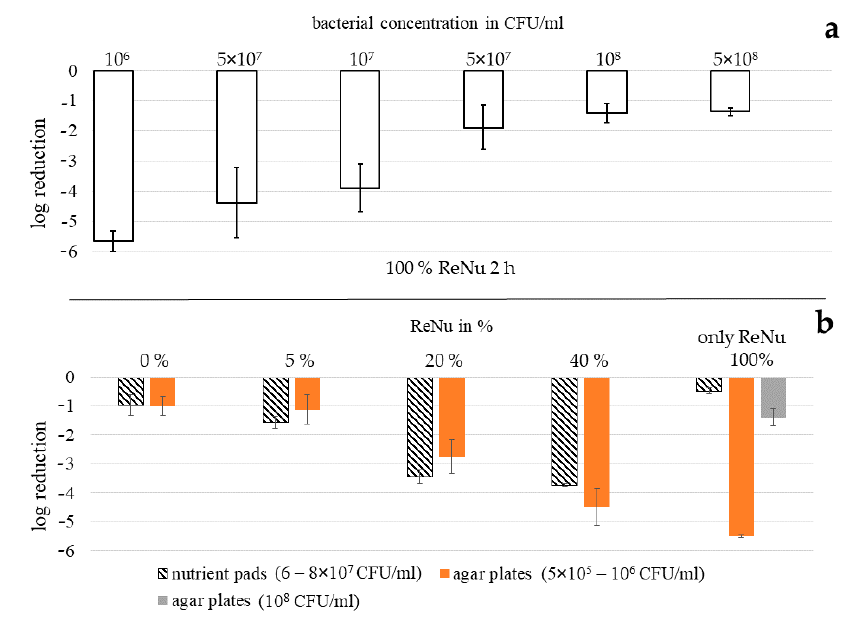
Figure 5. Effectiveness of undiluted ReNu Multiplus disinfection solution (100%) against P. fluorescens at different bacterial concentrations, tested with agar plates. Error bars indicate the deviation in the three experiments ( a ). Comparison of log results with nutrient pads and agar plates for combination of ReNu Multiplus and visible 405 nm light at 20 mW/cm 2 for 140 J/cm 2 . Error bars indicate the deviation in the three experiments ( b ).